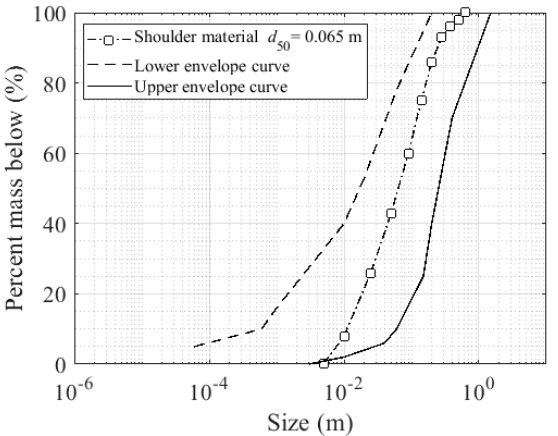
Figure 4. Grain size distribution enveloping curves from dam database and for chosen shell material (scaled up 10:1 to prototype scale) previously presented in [26].